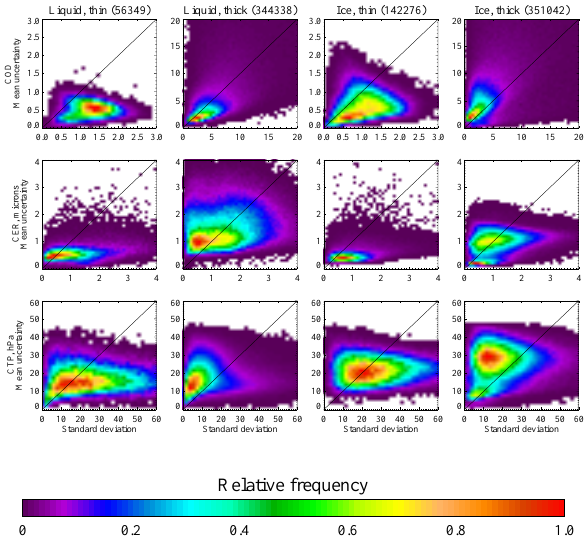
Fig. 5. Joint histograms of retrieval standard deviation and mean uncertainty estimate for clouds at sea gridded to 0.5 degree resolu- tion. From top to bottom, rows show the cloud optical depth, cloud effective radius, and cloud-top pressure. From left to right, columns show optically-thin liquid water clouds ( τ c < 10), optically-thick liquid water clouds ( τ c ≥ 10), optically-thin ice clouds ( τ c < 10), and optically-thick ice clouds ( τ c ≥ 10). The total number of re- trievals for a given cloud type is indicated at the top of the column. White indicates bins containing no data.